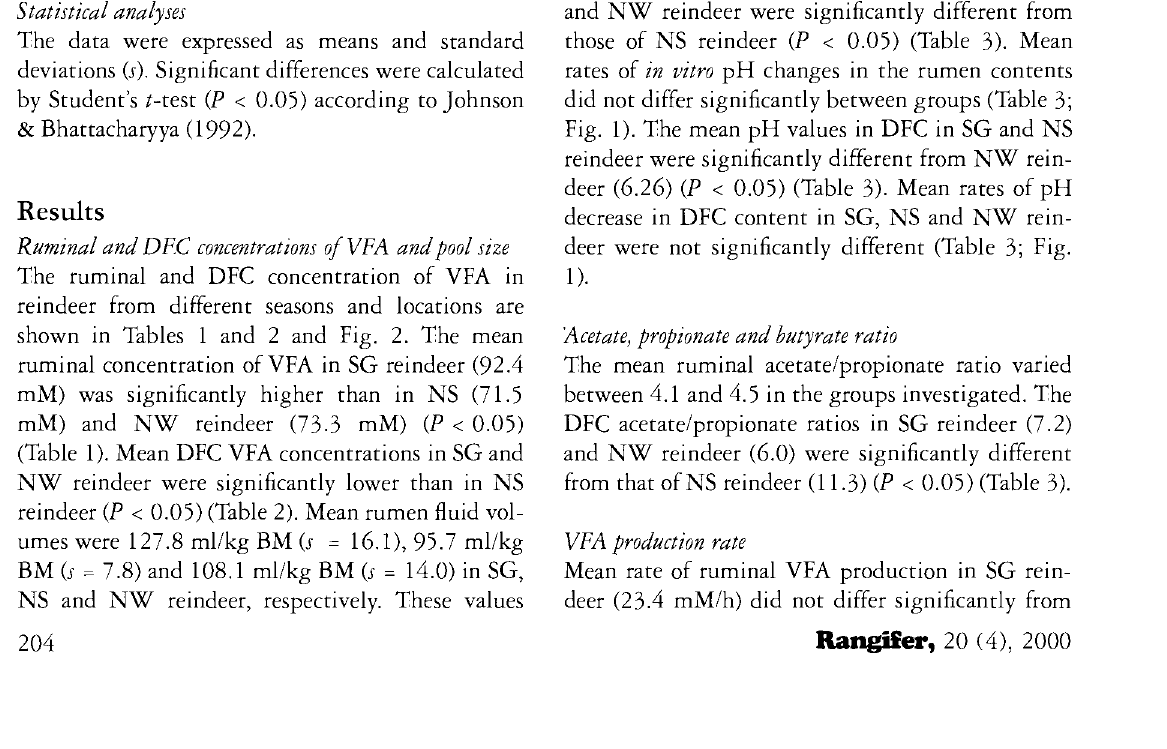
Table 3 and Fig. 1. Mean ruminal pH values in SG and NW reindeer were significantly different from those of NS reindeer (P < 0.05) (Table 3).